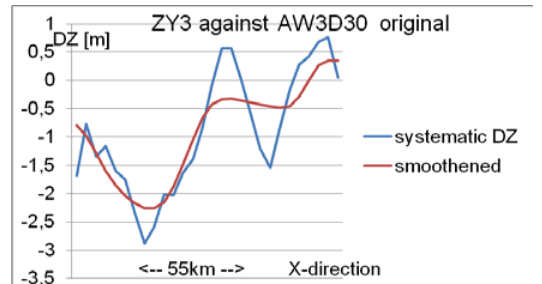
Figure 11. Systematic height errors in X-direction, Saintes- Maxime, ZY3 DSM against AW3D30 DSM